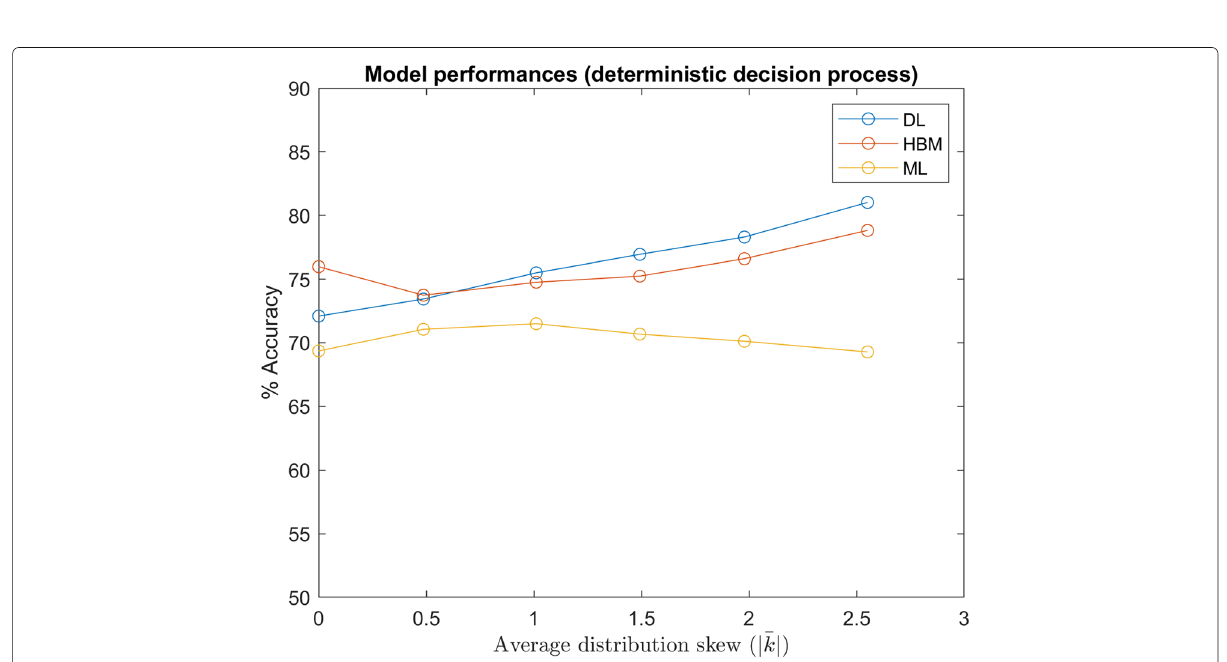
Fig. 12 Model Performances (Deterministic Decision Process): Comparison of the model performances (DL trained with 2,000 participants involved) over datasets with various underlying distributions of w , denoted by the approximate average of absolute shape factors k ( Gaussian distribution). In this test, decisions were simulated with the deterministic version of Eq.